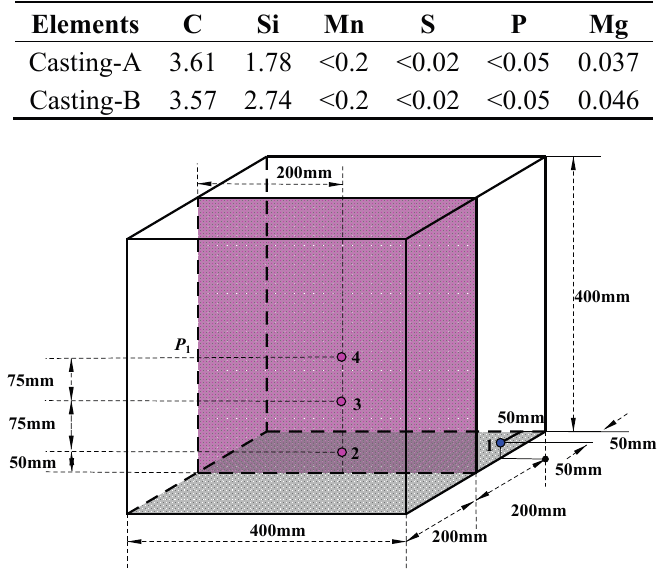
Table 2. Compositions of castings (wt.%).